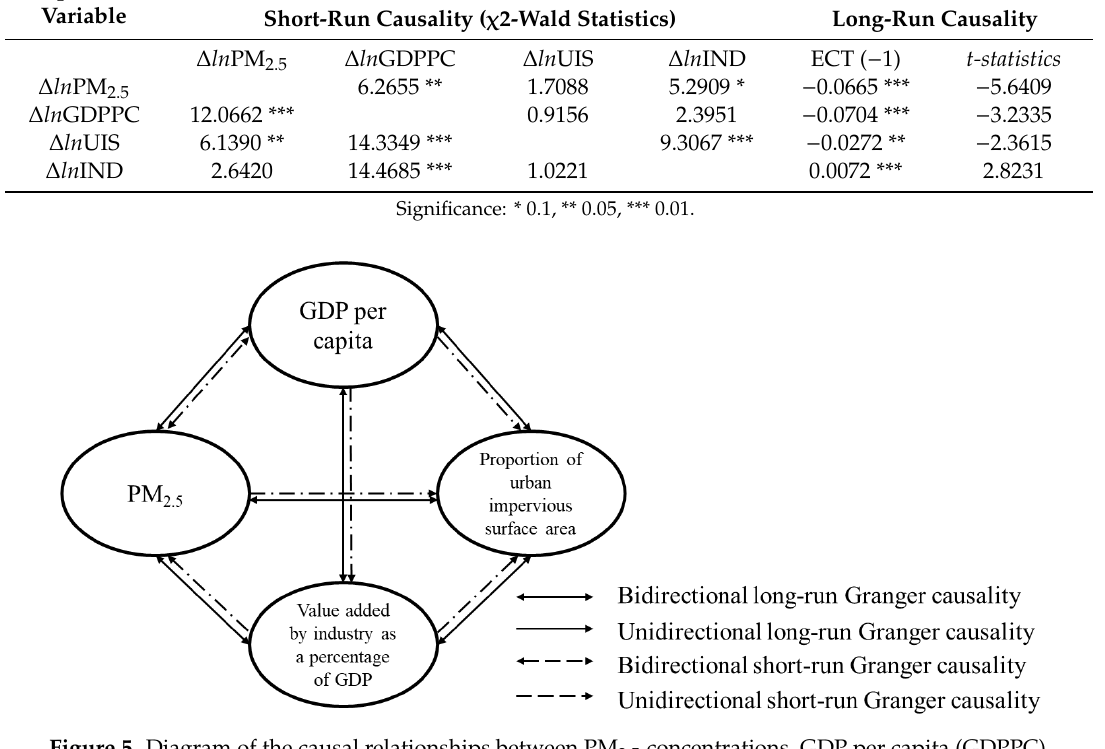
Figure 5. Diagram of the causal relationships between PM 2.5 concentrations, GDP per capita (GDPPC), the proportion of urban impervious surface area (UIS) and the value added by industry as a percentage of GDP (IND).